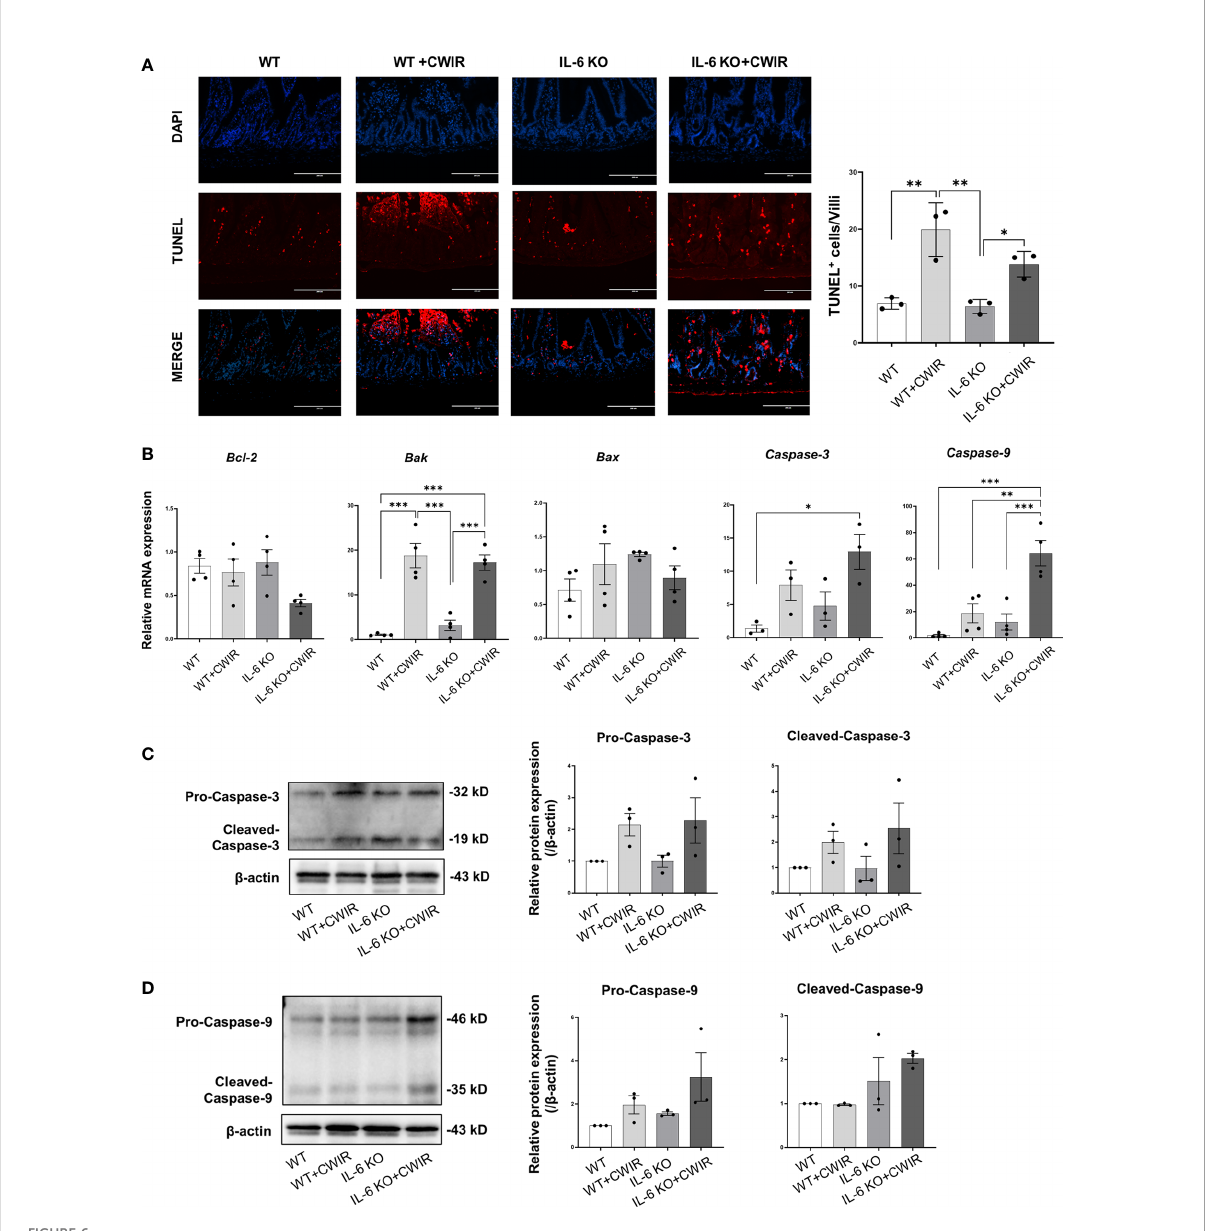
FIGURE 6 CWIR-caused jejunal epithelium apoptosis was relieved by IL-6 de fi ciency in mice. (A), Representative immuno fl uorescence micrographs of TUNEL (red) and DAPI (blue) staining in the intestinal epithelium. TUNEL positive cells per villi was quanti fi ed and exhibited. The scale bar means 200 m m. N=3. (B), The expressions of some apoptosis-related indicators among groups were examined at the transcriptional level. N=3-4. (C, D), Western blot results and quanti fi cation of pro and cleaved-caspase-3 and caspase-9 among groups. N=3, Data analysis was performed by two-way ANOVA with the Tukey post-hoc test. * P <0.05, ** P <0.01, *** p